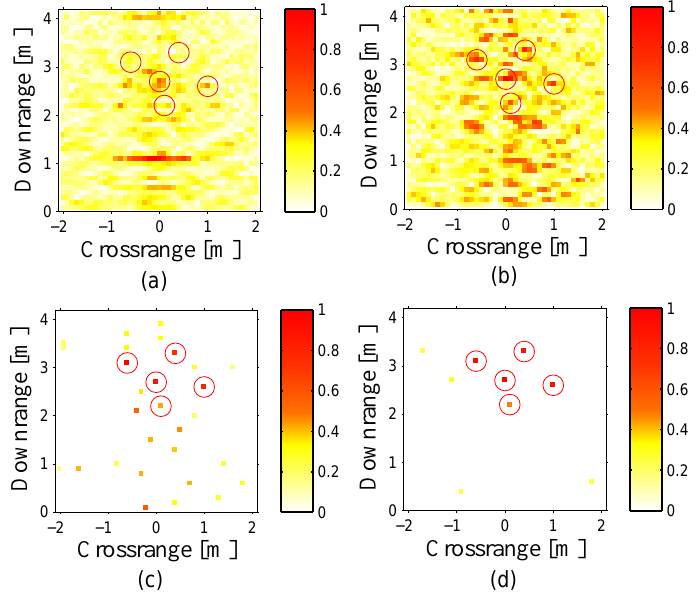
Figure 2. Comparison of targets’ reconstruction by existing methods and interaction compressive sensing (CS). ( a ) For the conventional delay and sum beamforming (DSBF) method without removing any kind of clutters; ( b ) for the DSBF method with front wall clutters removed; ( c ) for conventional CS with front wall clutters removed; and ( d ) for interaction CS with front wall clutters